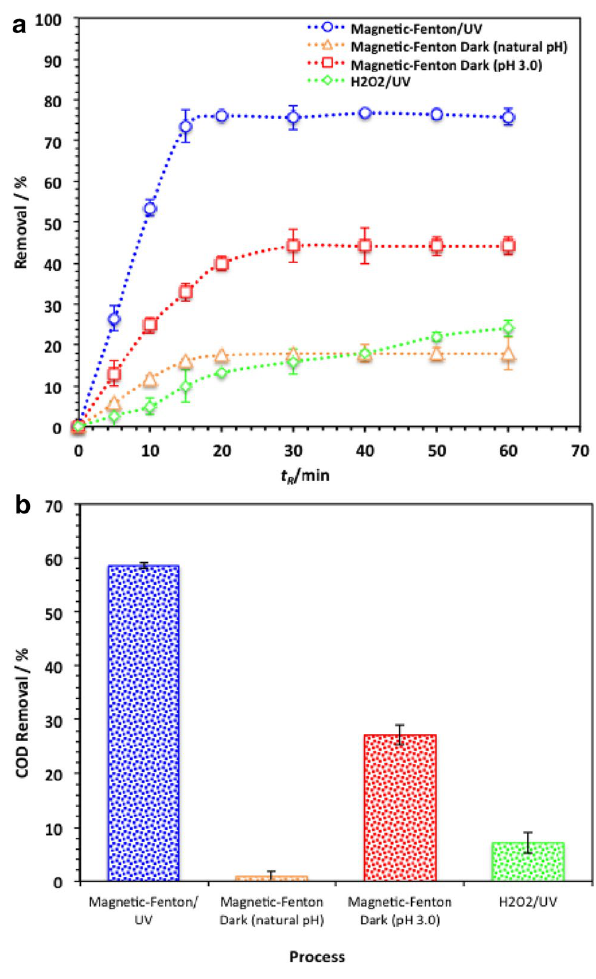
Fig. 4 Effect of different treatment systems on Synozol Blue removal ( a ) Colour removal; ( b ) COD